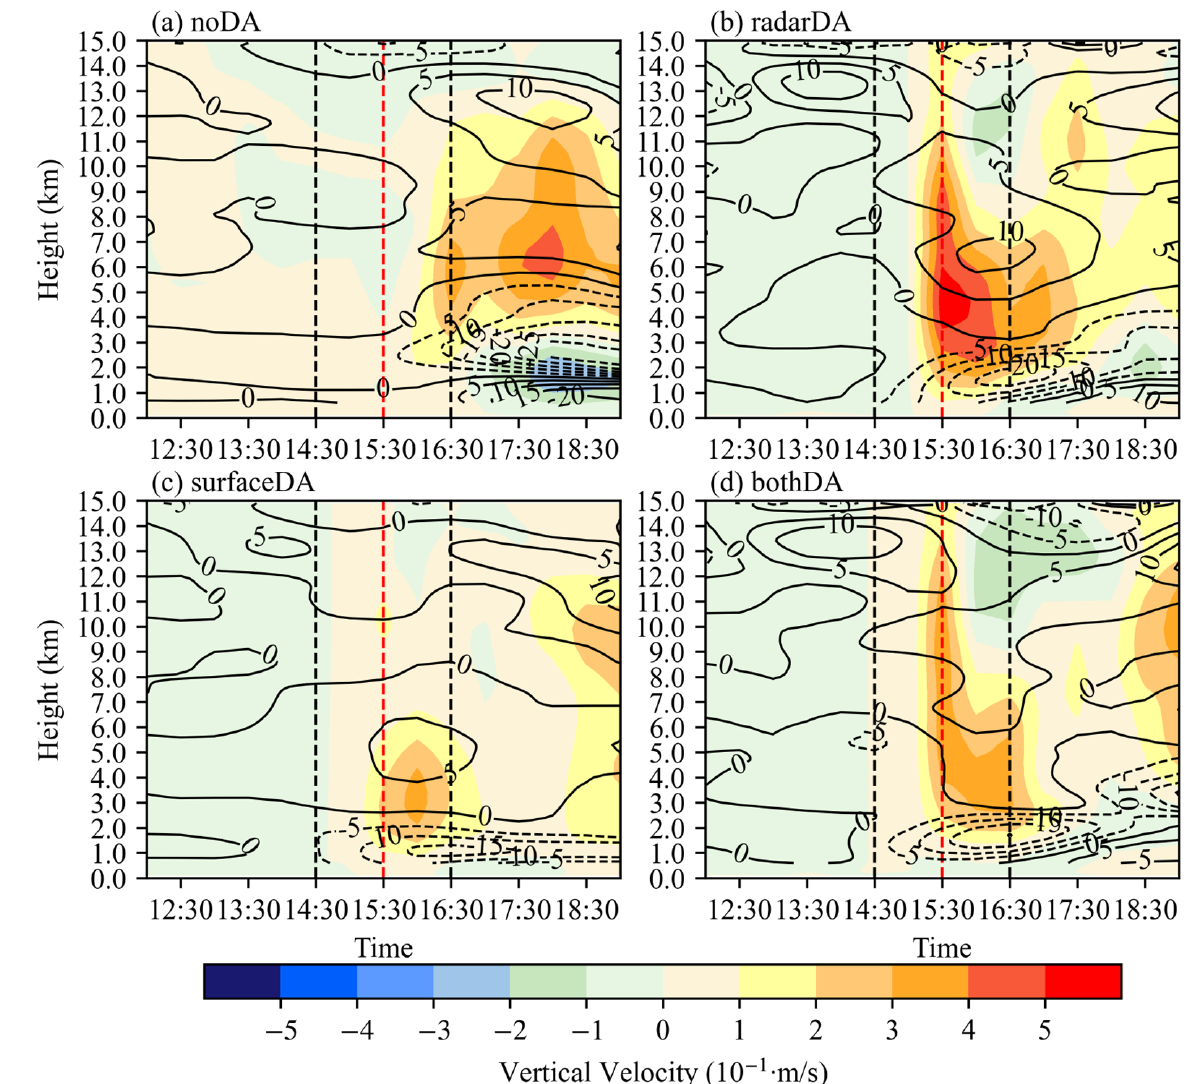
Figure 13. The time–height cross sections of area-averaged vertical velocity (shaded, units: 10 − 1 · m/s) and divergence (contour, units:10 − 5 · s − 1 ) from 1200 UTC to 1900 UTC 11 July 2014 for ( a ) noDA, ( b ) radarDA, ( c ) surfaceDA and ( d ) bothDA experiments. The averaged area is denoted by the black box in Figure 12. The red dotted line represents the time of the squall line initiation, and the two black dotted lines represent the time near the squall line initiation.